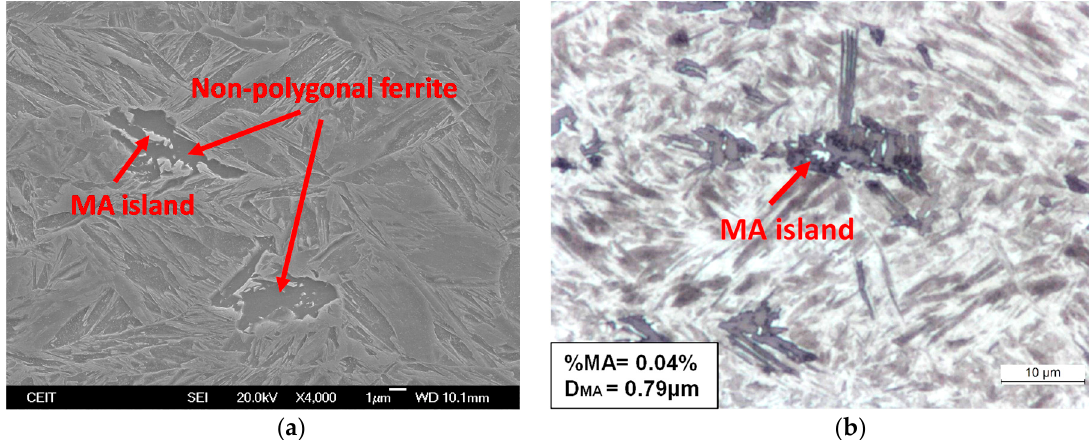
Figure 9. Presence of non-polygonal ferrite within martensitic matrix and martensite-austenite (MA) islands in CMnNbB steel: ( a ) FEGSEM micrograph and ( b ) optical image after LePera colour etching.